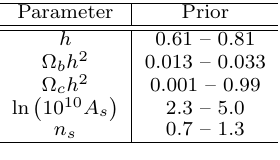
Table 3 Cosmological parameter priors used in this analysis. All the priors are